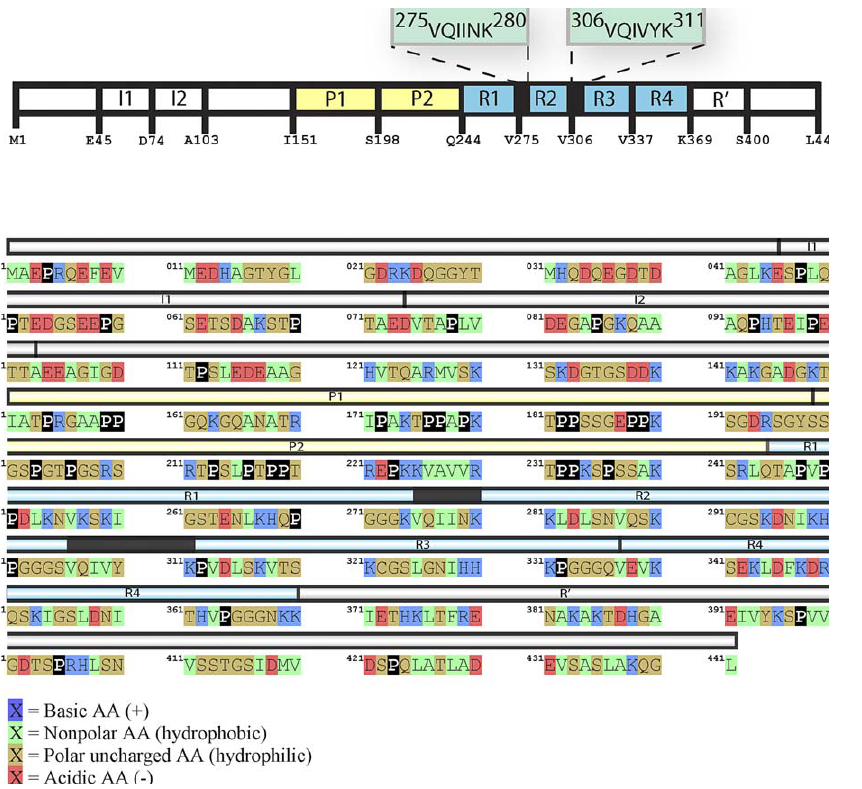
Figure 1. Primary Sequence of 441-Residue Tau (A) Domain organization of htau40. The isoform htau40 is the largest one in the human central nervous system (441 residues). Depending on isoform, the C-terminal half contains three or four pseudorepeats ( ; 31 residues each, R1–R4, cyan), which are involved in MT binding and form the core of PHFs. The two hexapeptides that are essential for aggregation of tau into PHFs are highlighted. P1 and P2 are the proline rich regions. Domain boundaries are labelled by the residue numbers. (B) Amino acid sequence of htau40. Amino acids are colour coded according to their properties: basic (blue), non-polar (green), polar uncharged (brown), acidic (red). On top of the amino acid sequence, the domain organization is indicated. The two hexapeptides in repeats R2 and R3 are shown as black bars. doi:10.1371/journal.pbio.1000034.g001 PLoS Biology |